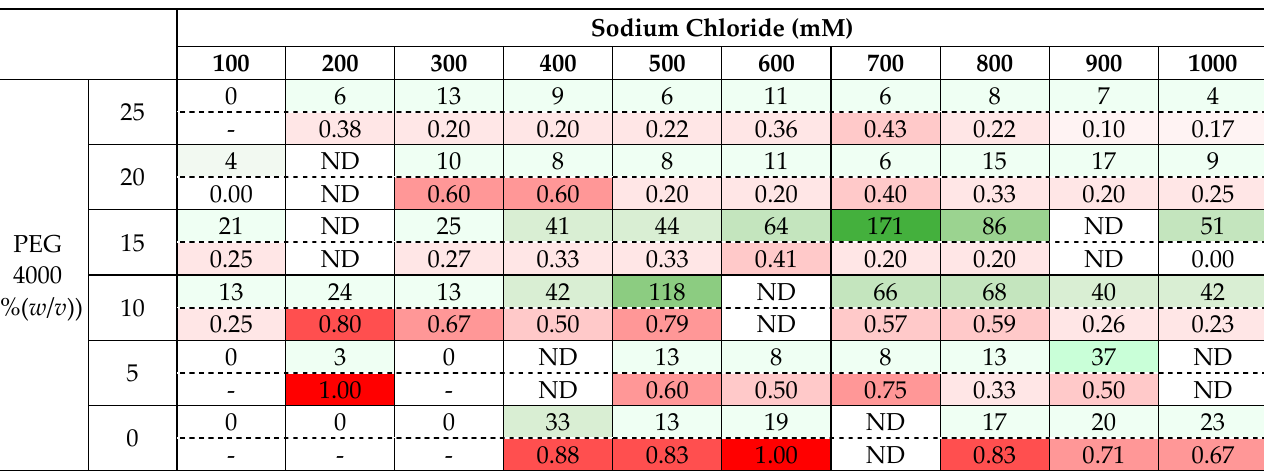
Table 1. Number of crystals in unit volume and the ratio of single crystals of lysozyme grown by microbatch crystallization in sodium chloride and PEG 4000. The table shows the number of crystals per unit volume (1 µ L) (top number) and the ratio of single crystals to all crystals (bottom number) seven days after crystallization setup.